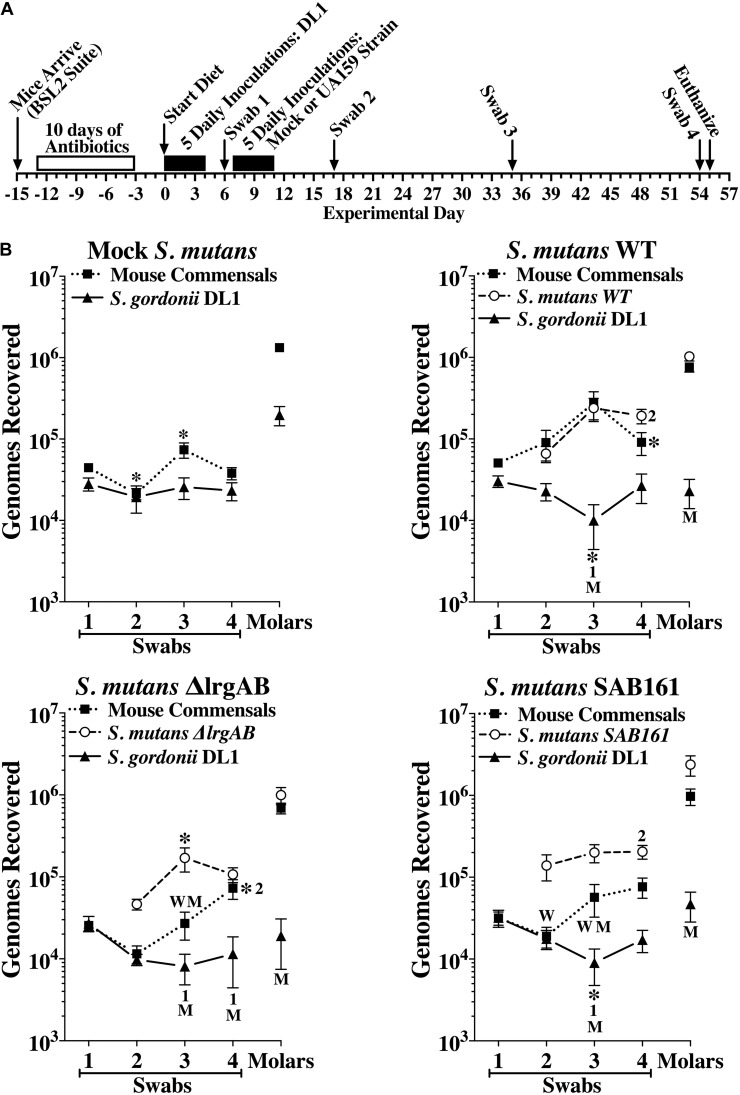
Colonization of the oral cavity and mandibular molars of mice by wild type S. mutans UA159 (WT), ΔlrgAB (lrgAB-deficient) and SAB161 (lrgAB-overexpressing) strains with S. gordonii DL1. (A) Timeline of key events in the experiment (see section “Materials and Methods” for details). (B) Colonization results for each indicated inoculated strain and mouse oral commensals (Commensals) from oral swabs 1–4 and from sonicates of mandibular molars taken at experimental days indicated in the timeline. Results are mean ± SE (n = 20 mice per group) of recovered genomes estimated by qPCR. Statistical comparisons by one-way ANOVA with Tukey-Kramer multiple comparisons test. *p ≤ 0.05 versus the previous swab or an earlier swab as indicated by the swab number, or versus the same point in either the mock (M) or wild type (W) group.